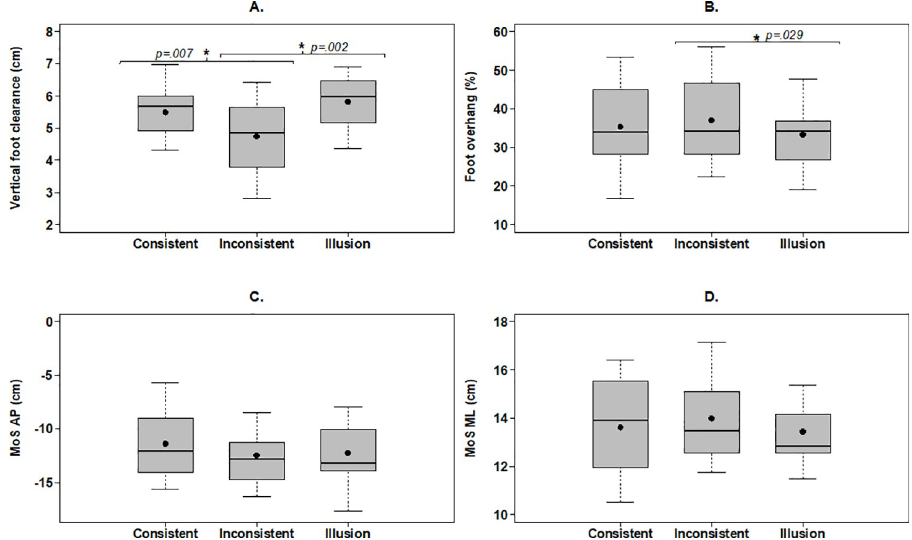
Fig 3. Outcome measures on step 5. (A) Vertical foot clearance. (B) Foot overhang. (C) Anteroposterior MoS. (D) Mediolateral MoS. Box plots present the mean ( ⬤ ) and median (-). � Denotes significant difference between conditions inside brackets. Foot overhang represents percentages of foot length. Negative anteroposterior MoS values represent an xCoM ahead (anterior) of the boundary of support. Positive mediolateral values represent an xCoM that is inside (medial) the boundary of